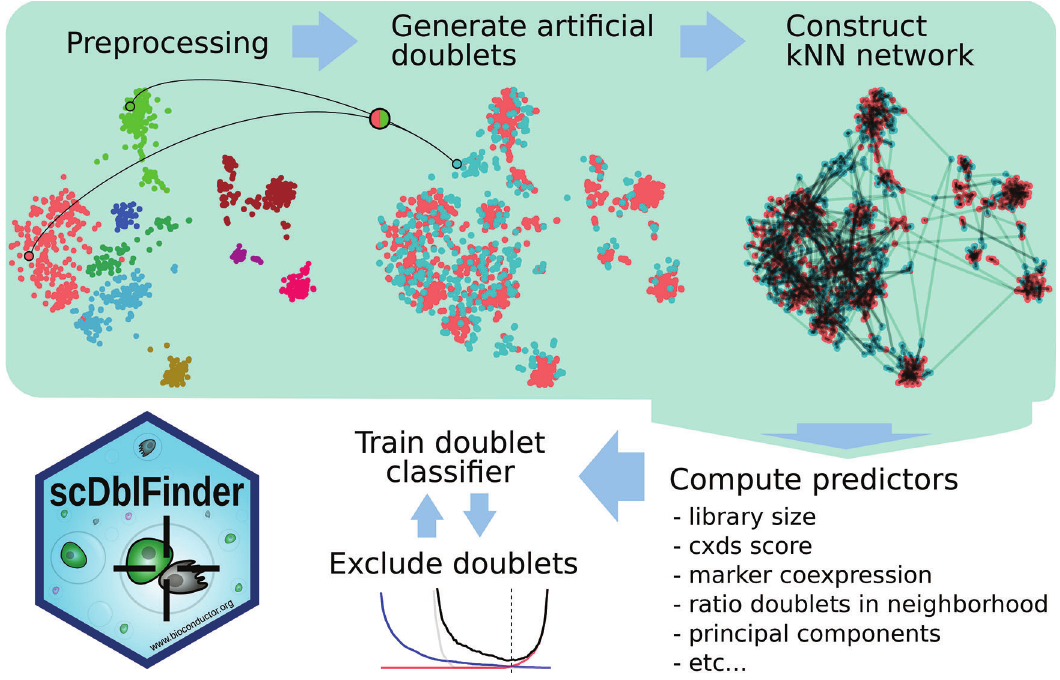
Figure 2. Overview of the scDblFinder